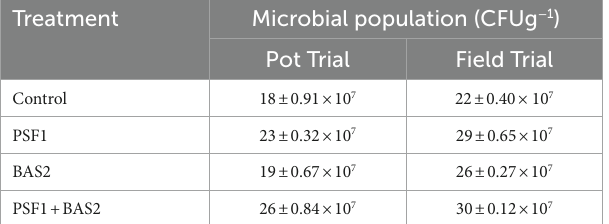
TABLE 3 Rhizospheric microbial